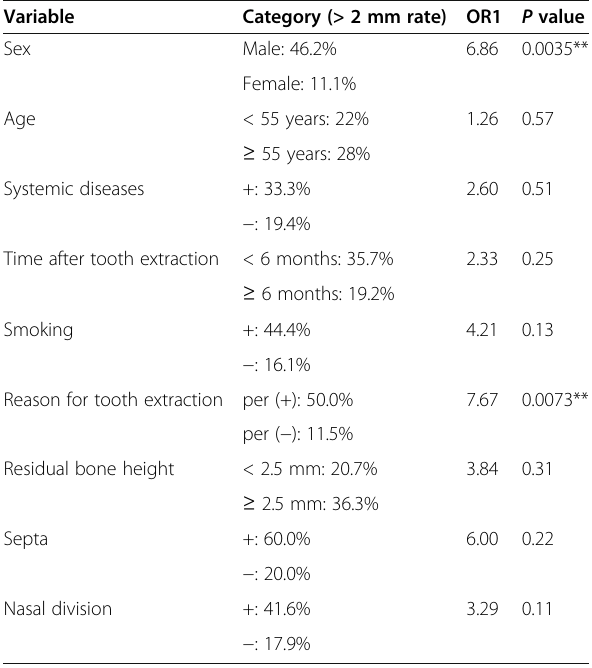
Table 3 Factors influencing sinus mucosal thickness (> 2 mm